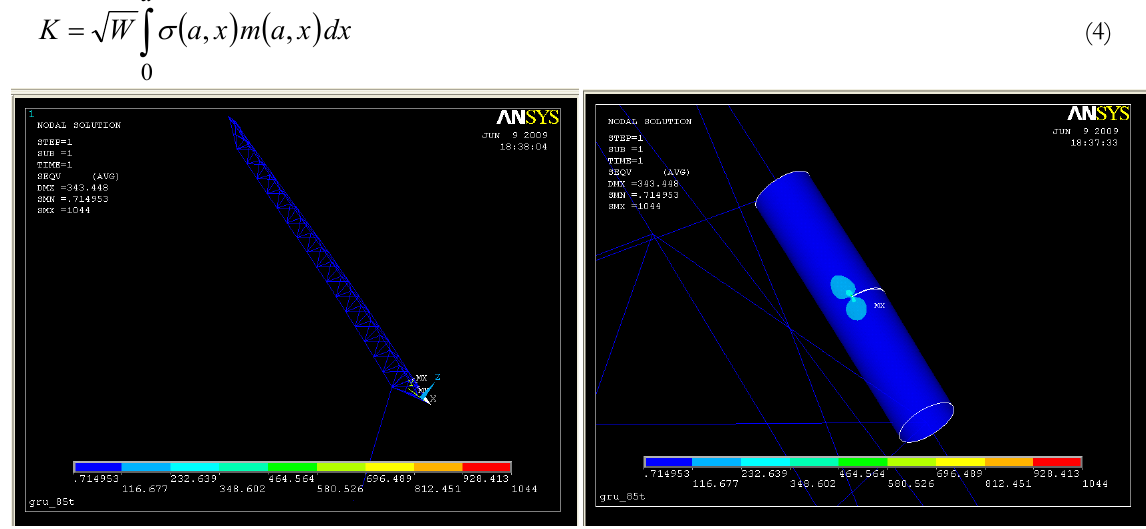
Figura 5: Modello impiegato per valutare le caratteristiche di sollecitazione nella sezione contenente il